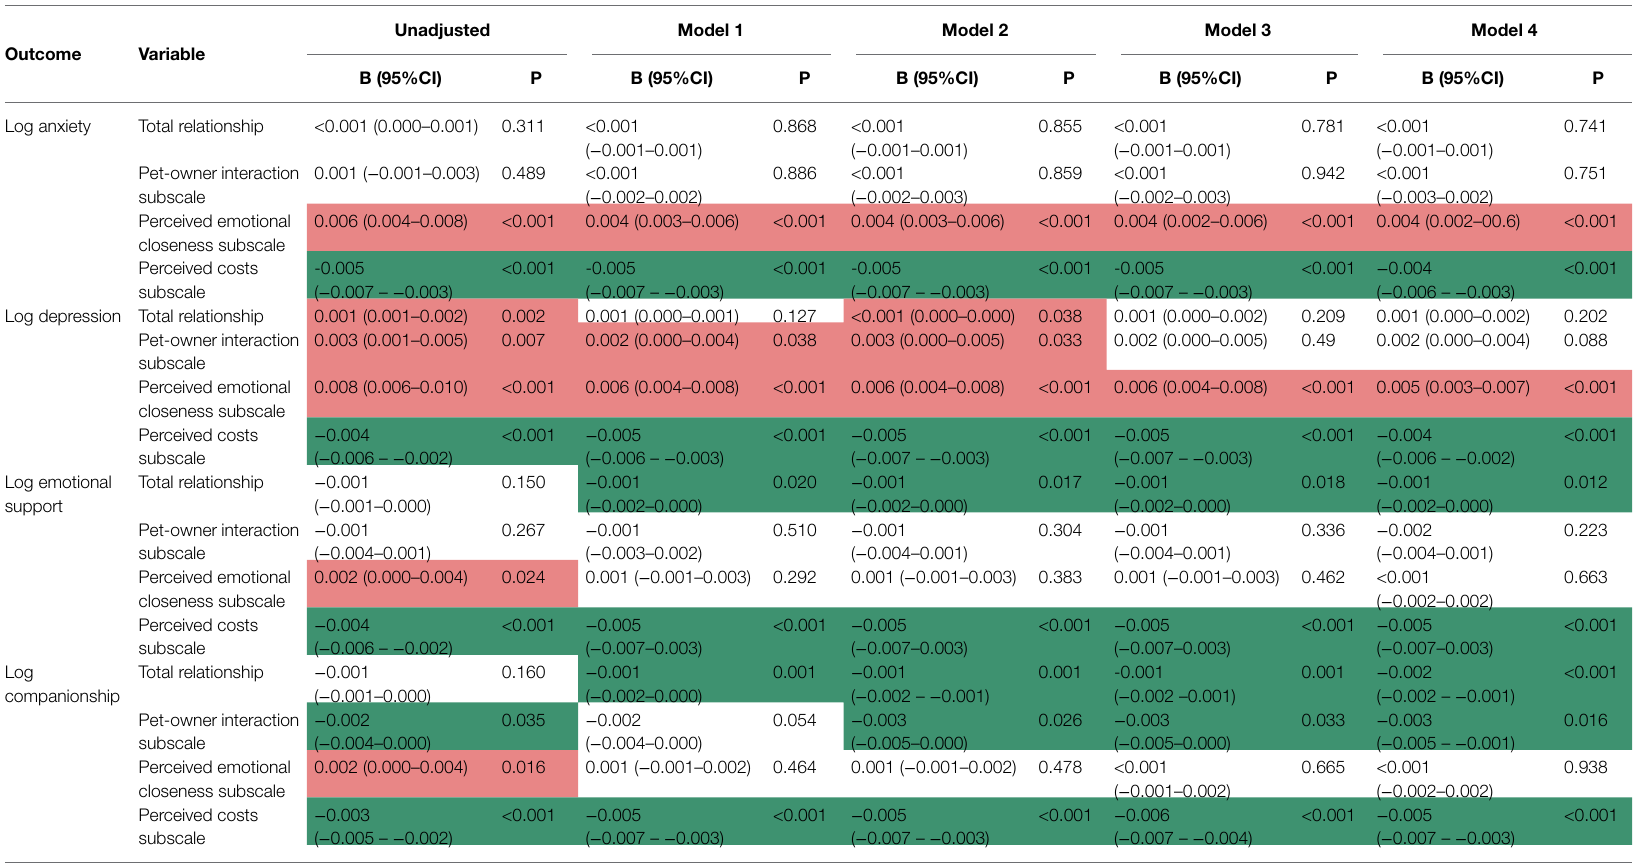
TABLE 3 | Linear regression examining whether pet-owner interaction, perceived emotional closeness, perceived costs and their sum are predictors of poorer mental health outcomes